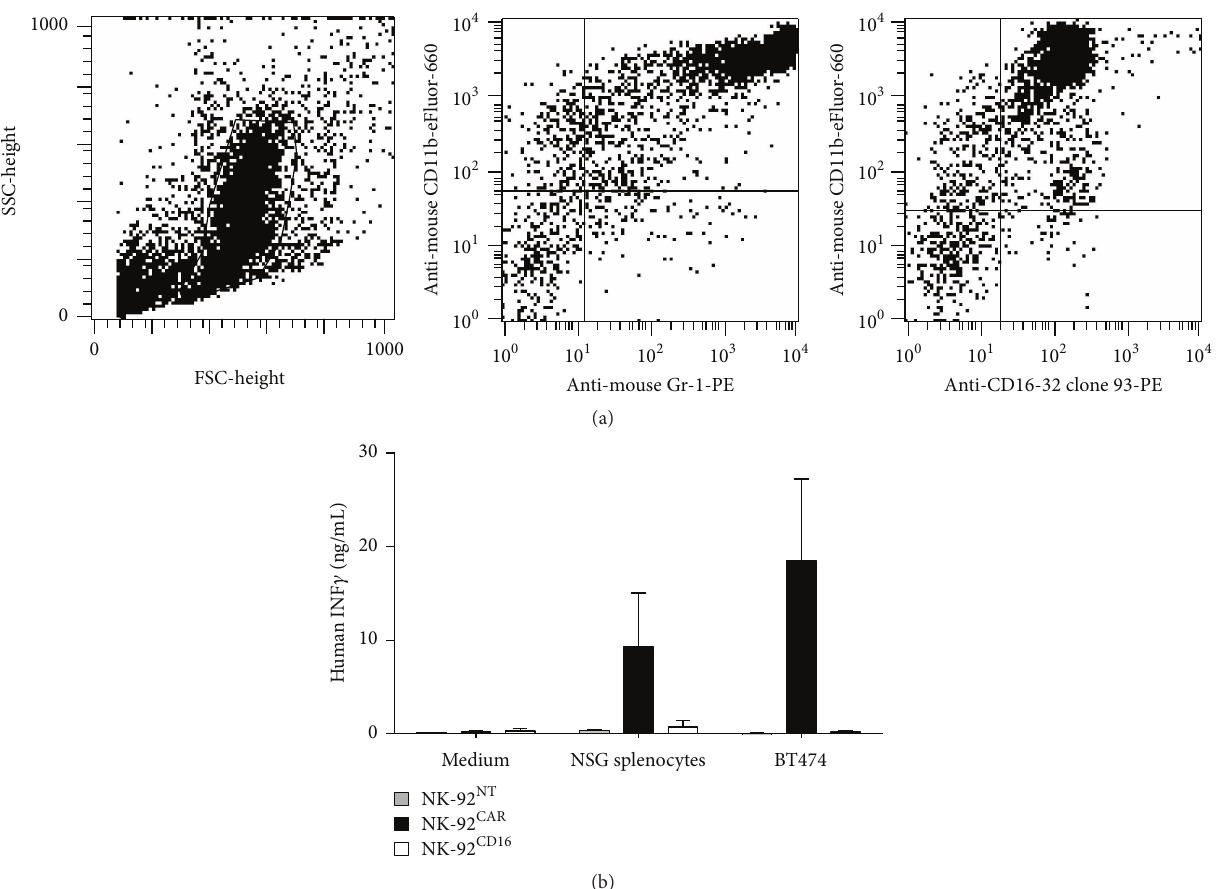
Figure 7: NK- 92 CAR stimulation after coculture in the presence of NSG splenocytes. (a) Single-cell suspensions from NSG mice spleens were stained with an antibody cocktail and then analyzed by flow cytometry for expression of CD11b (Mac-1) versus Gr-1 (Ly-6G) and CD11b versus CD16/32 (FcR 𝛾 RIII/FcR 𝛾 RII). (b) NK-92 (NK- 92 NT , NK- 92 CD 16 , or NK- 92 CAR ) and splenocytes from NSG mice or the HER2 positive cell line BT474 were cocultured at an effector ratio of 5 :1 and 2: 1, respectively, in 96-well round bottom culture plates in RPMI 1640 supplemented with 10% FCS and IL2 (100IU/ML). After 18 h, supernatants were collected and human INF- 𝛾 content was estimated using an ELISA kit (Affymetrix, e-biosciences). Data represent the mean with SD from three independent